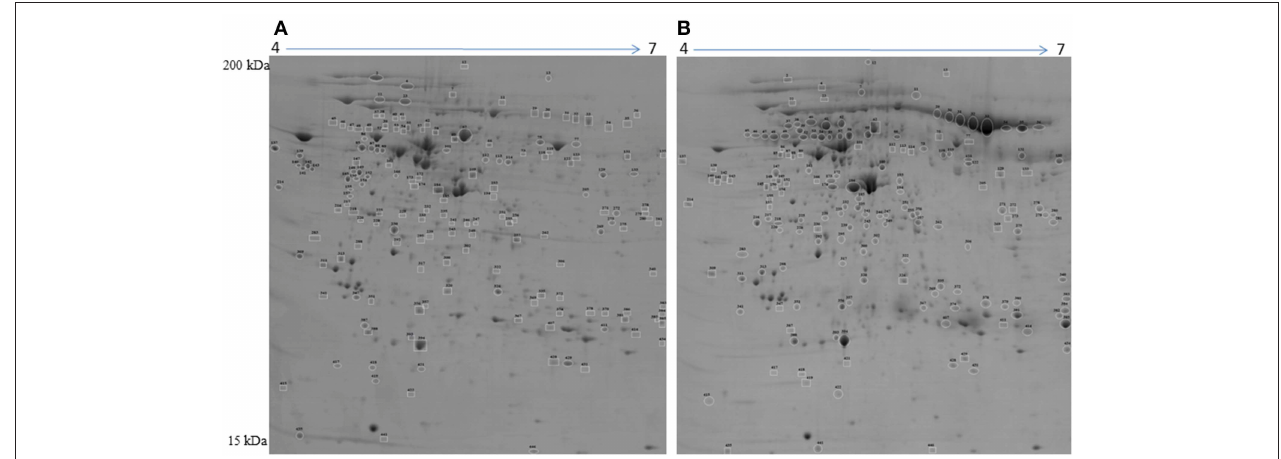
FIGURE 2 | Representative 2D gel image illustrating comparison between (A) preovulatory follicles and (B) newly formed corpus luteum proteomes. Significantly altered spots ( P < 0.05) with at least 1.8-fold changes in intensity were identified as upregulated (circles) or downregulated (squares) in POFs or the CL. Spot numbers correspond to the proteins that were identified by mass spectrometry analysis and are presented in Table 2 . Images are representative of four gel